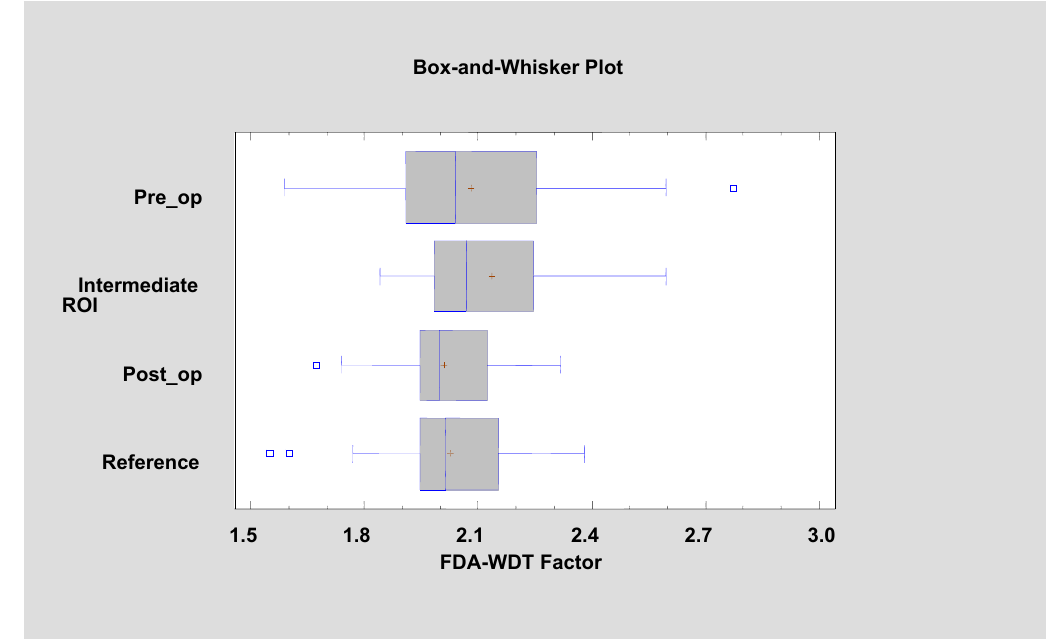
Figure 11. Factor 2 (fractal dimension analysis–wavelet discrete transform factor, FDA–WDT factor) calculated for the tested patients (Kruskal–Wallis test = 4.149, p = 0.246).